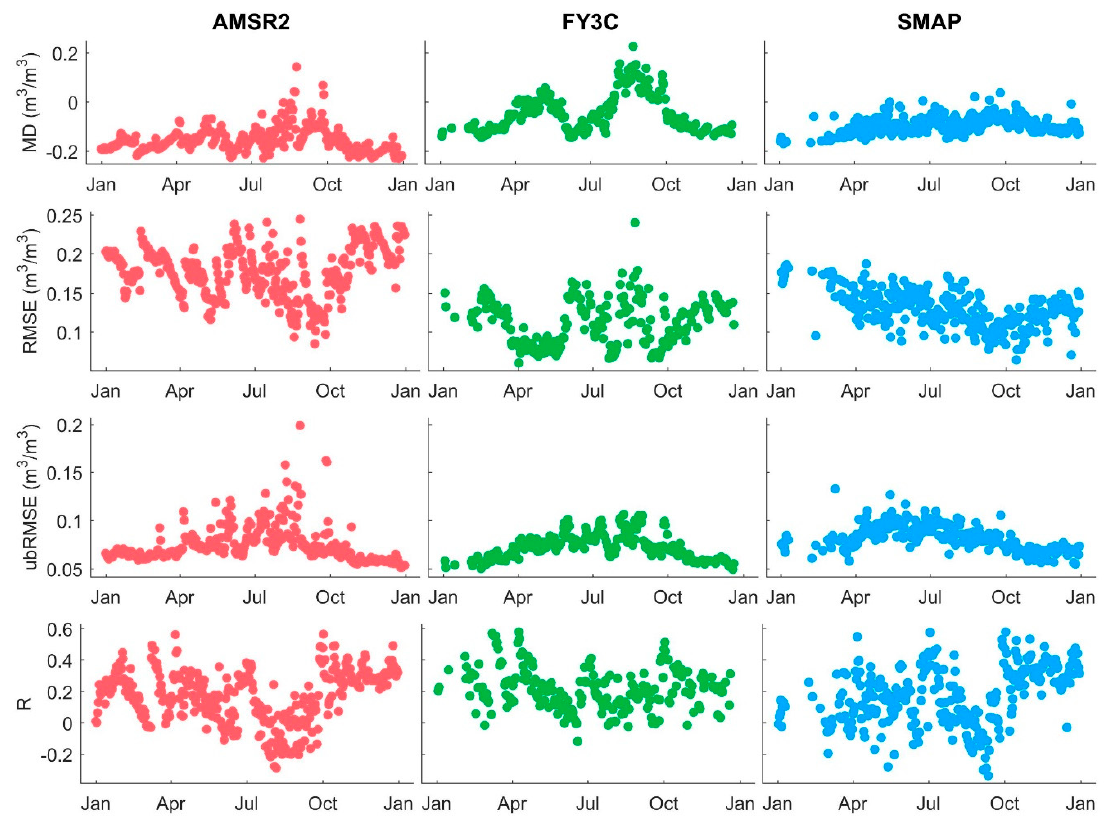
Figure 10. The temporal evolution of the statistical parameters of FY-3C, AMSR2, and SMAP in 2016. Table 7. Monthly averaged statistics for FY-3C, AMSR2, and SMAP in 2016. Mean difference (MD),